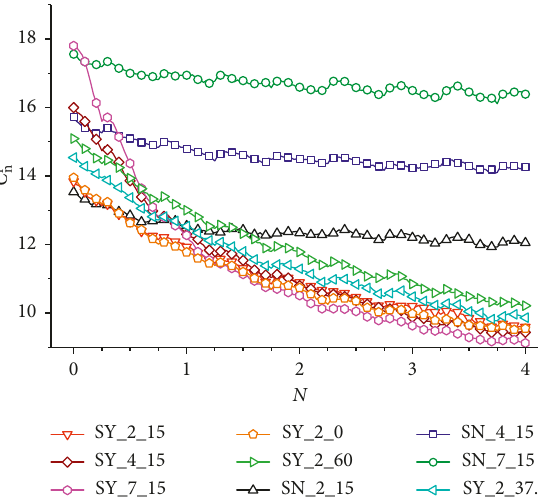
Figure 24: Evolution of the coordination number for particles ). ( C p n